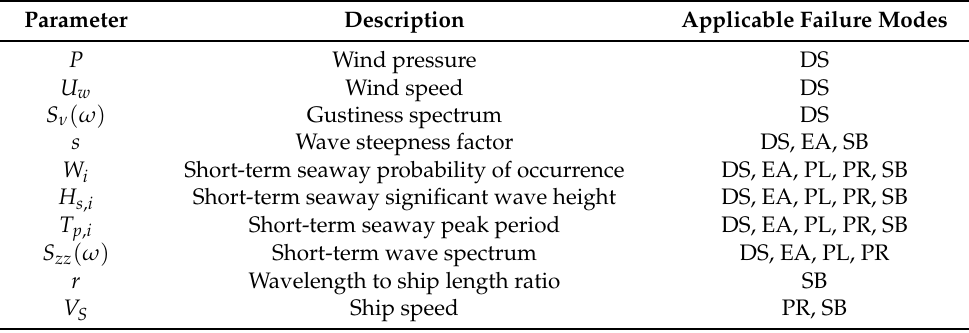
Table 2. Summary of input parameters which may be varied to match specific operating